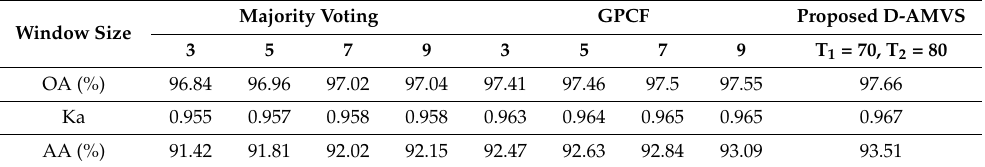
Table 7. Comparisons of the proposed D-AMVS and different post-classification approaches for the Pavia Center